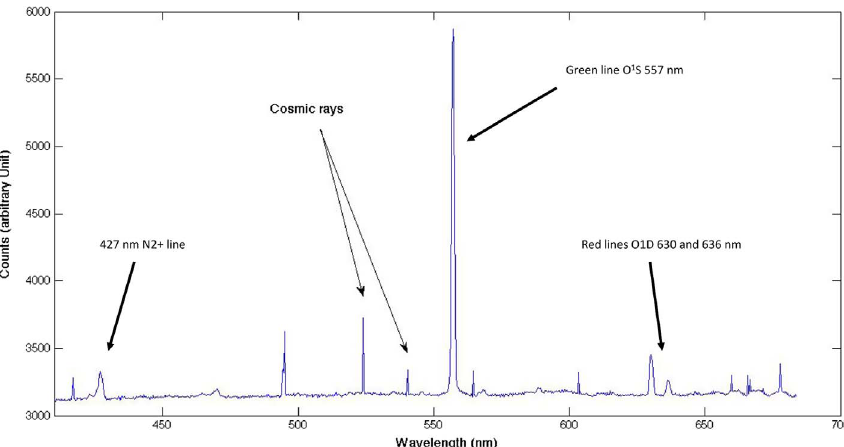
Fig. 3. Spectrum of the ordinary beam with the HWR position at 0 (cid:3) acquired on March 2, 2017 at 19:38. The cosmic rays mentioned in the text are the strong and thin peaks while the auroral lines are much wider due to the aperture of the slit. Two of them are pointed in the fi